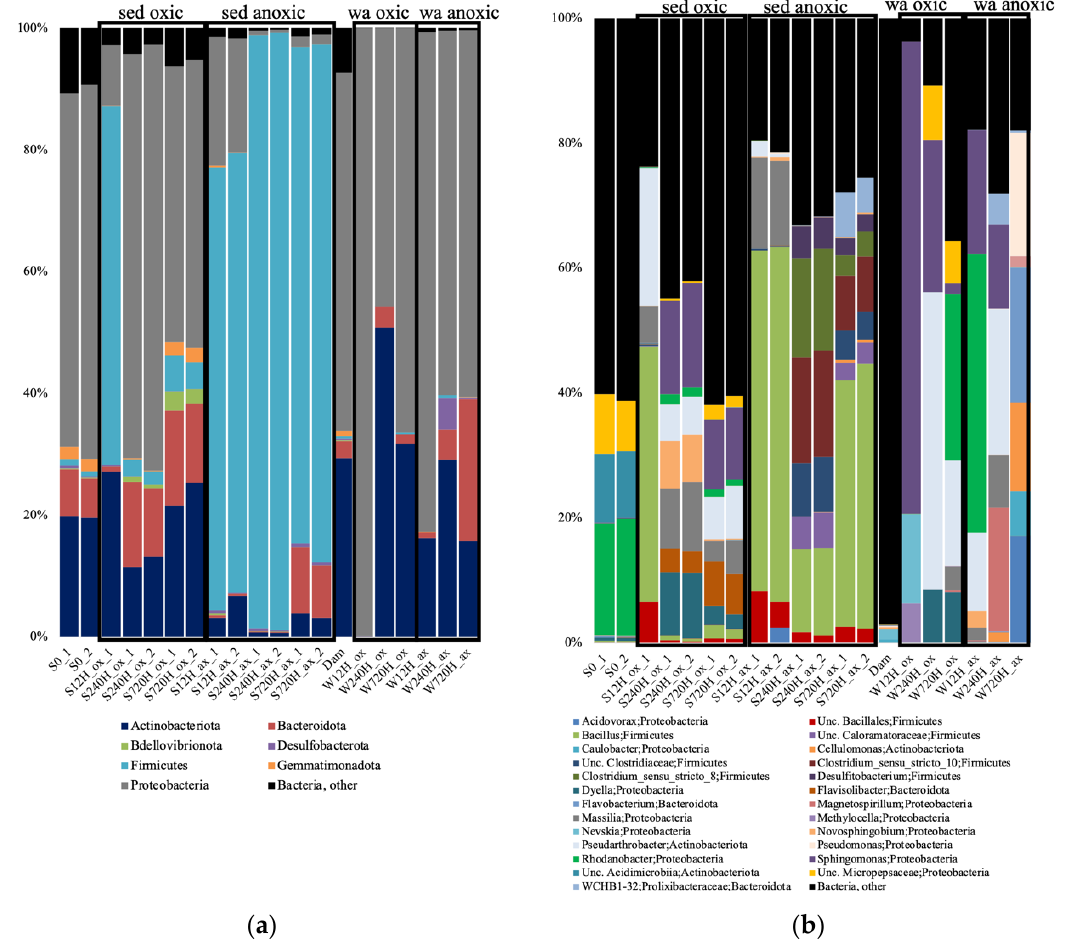
Figure 5. Relative abundance of the bacterial taxonomic groups at the phylum ( a ); and genus ( b ) levels, in the oxic (ox) and anoxic (ax) incubations, in the sediment (S) and water (W) samples and for both duplicates (_1 and _2). Relative abundance is expressed in percentage of the total number of sequences for each sample. S0, initial sediment before incubation; Dam, dam lake water sample; Unc, unclassified; sed, sediment; wa, water.